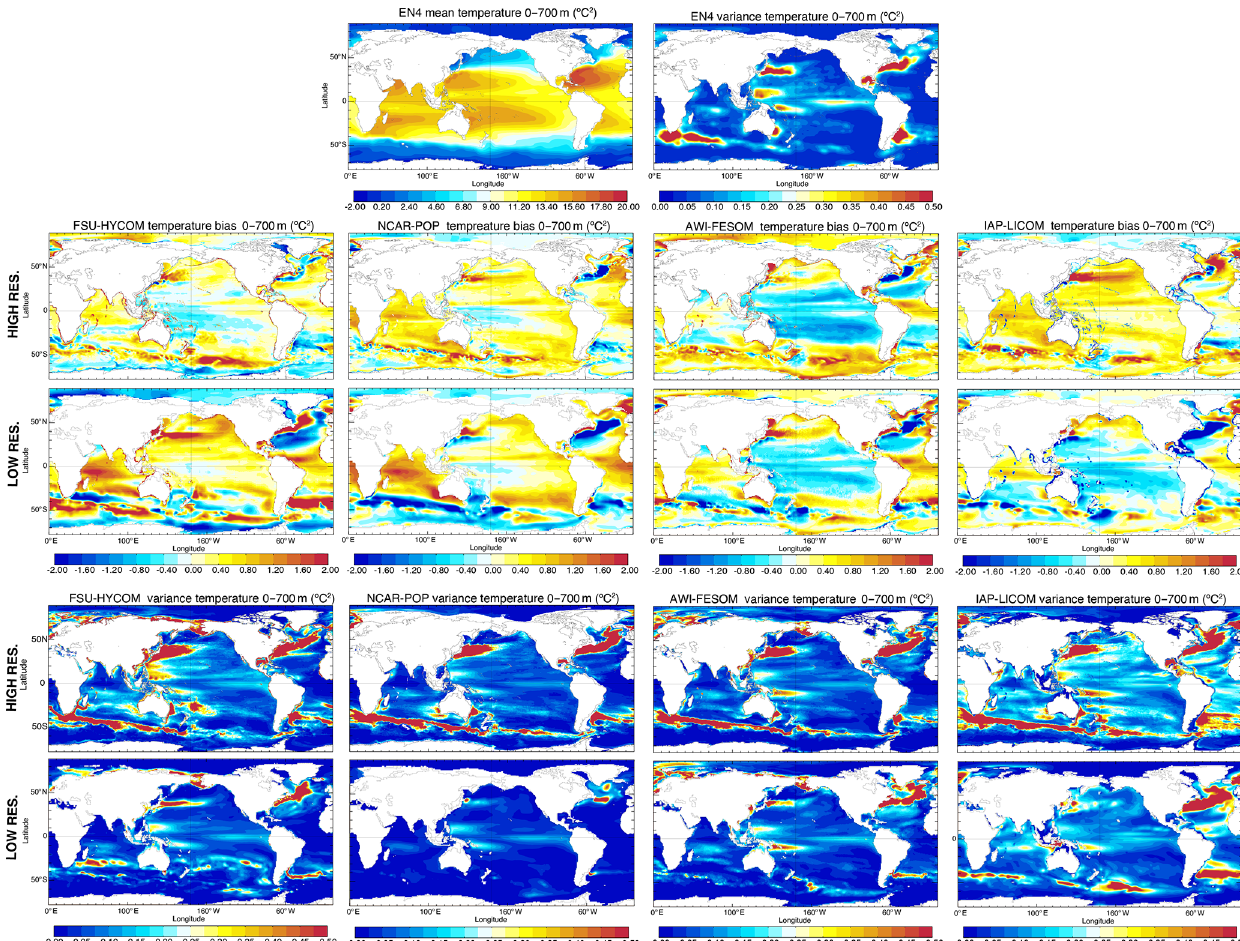
Figure 24. Top panels: mean 1980–2018 0–700m temperature and variance from EN4. Middle panels: difference between the mean modeled 1980–2018 0–700m temperature and EN4. Bottom panels: deseasonalized 0–700m temperature modeled